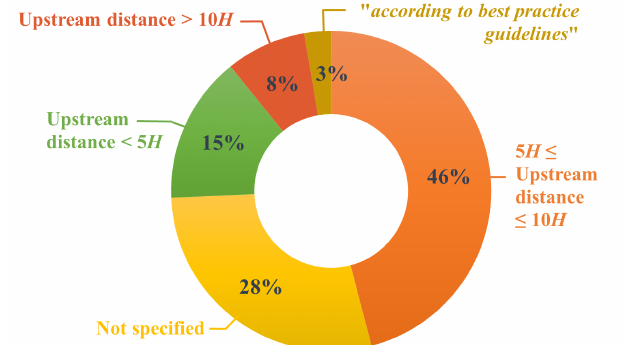
Figure 9. Upstream distance